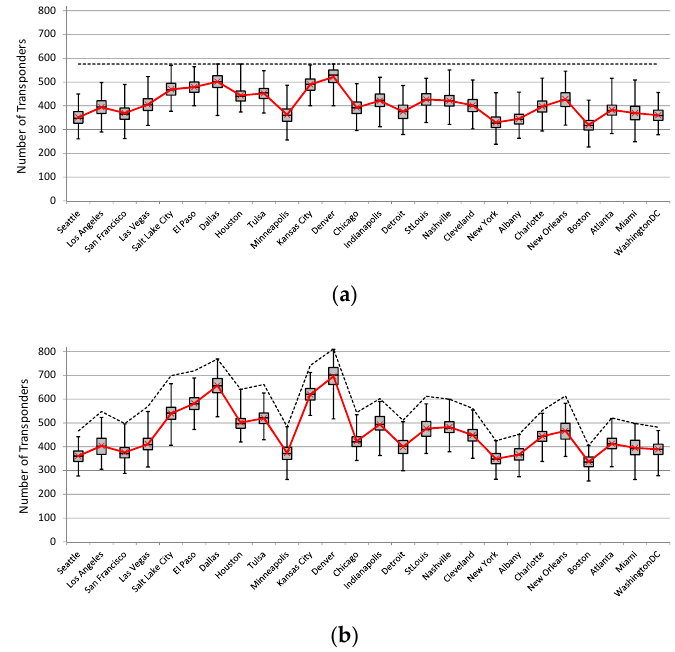
Figure 15. Box graph with placement of transponders given by: ( a ) UNI and ( b ) SAUR algorithms, for the US26 network, TP B, and 15,000 transponders. The dotted line shows the number of transponders in each node according to a particular algorithm. The red line represents the average observed values of transponder usage, while the boxes show data through their quartiles.